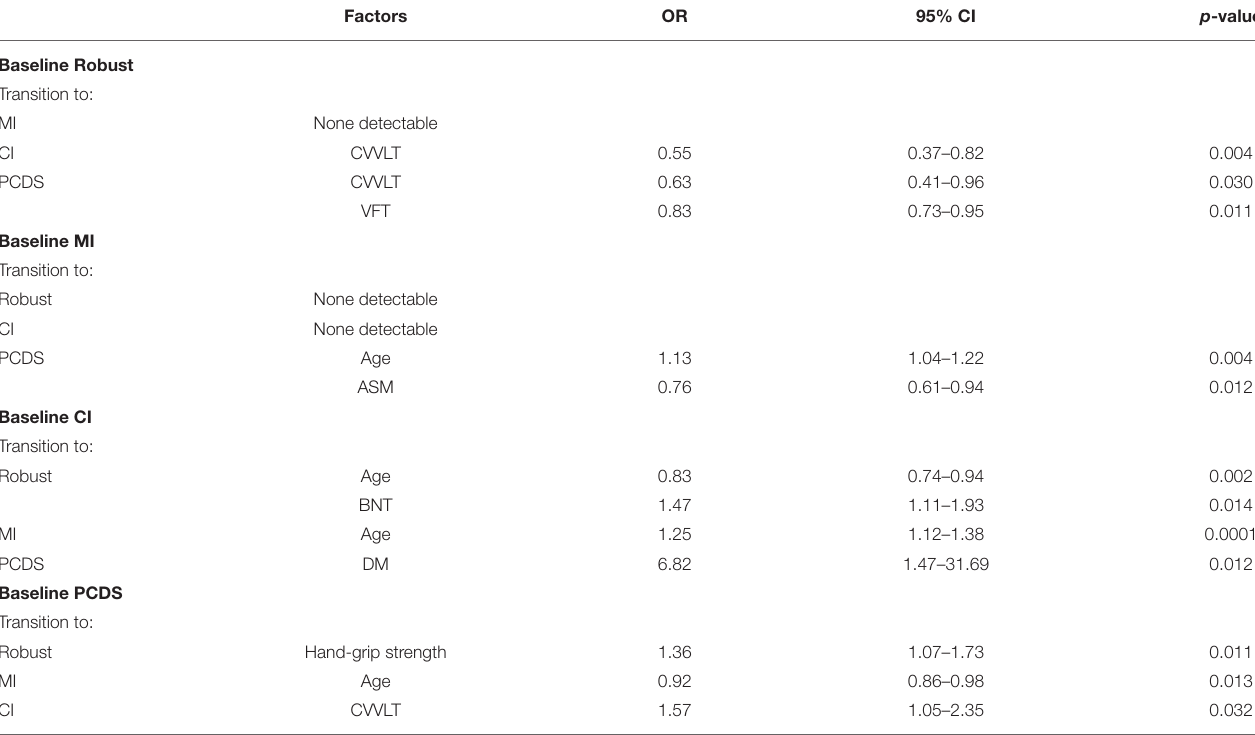
TABLE 3 | Statistically significant factors affecting categorical transitions in a 2.5-year follow-up revealed by multivariate binomial logistic regression. Factors OR 95% CI p